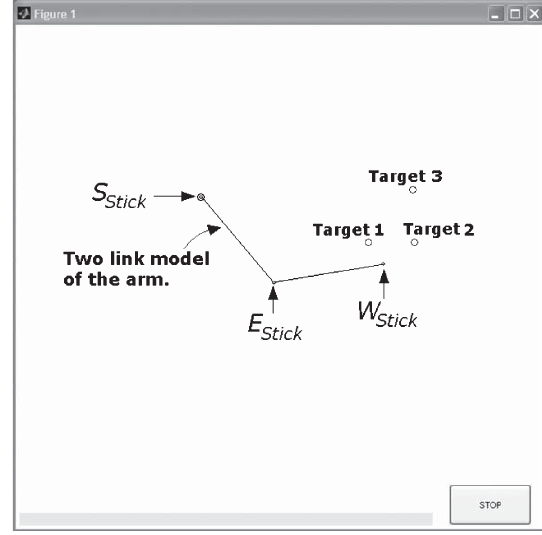
Fig. 6. Screenshot of the biofeedback environment used for practicing movements with the RUPERT system. S stick is the shoulder location, E stick is elbow location, and W stick is the location of endpoint.